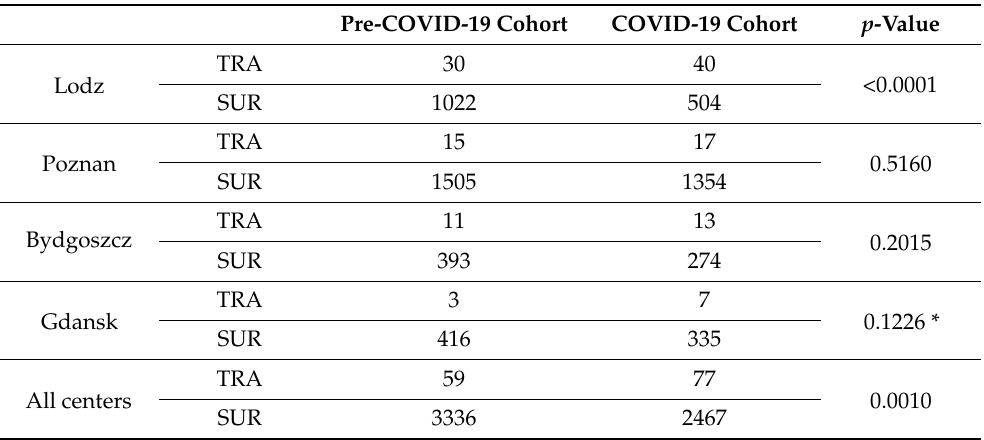
Table 1. Number of tracheotomy procedures, total number of ENT surgeries, and the incidence proportions for tracheotomy due to head and neck cancer in pre-COVID-19 and COVID-19 time cohorts. TRA—Urgent tracheotomy; SUR—Total number of ENT surgical procedures exclud- ing